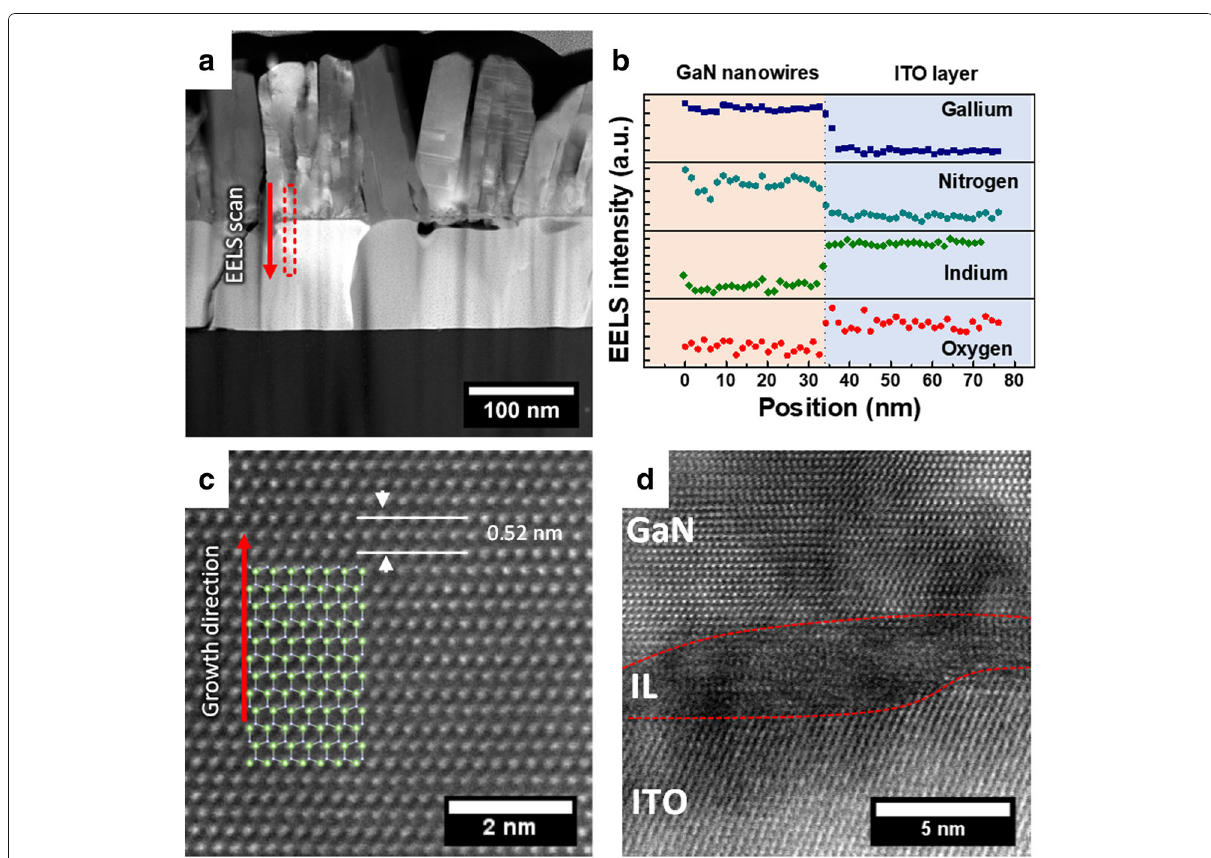
Fig. 3 TEM and elemental mapping of GaN nanowires grown on ITO layer. a HAADF image of GaN nanowires directly grown on top of the ITO layer. The red box indicates where the EELS line scan was performed. b EELS line scan profile of the interface between the base of GaN nanowire and ITO layer. The elemental mapping for Ga, In, N, and O are shown in the graph. c High-resolution TEM of the GaN nanowire, showing single crystallinity. The red arrow indicates growth direction. The interplane spacing corresponds to GaN c-plane. d High-resolution TEM image of the interface between the GaN nanowire and ITO layer. A partially amorphous intermediate layer (IL) can be seen between the GaN nanowires and ITO layer, bound by the dashed red